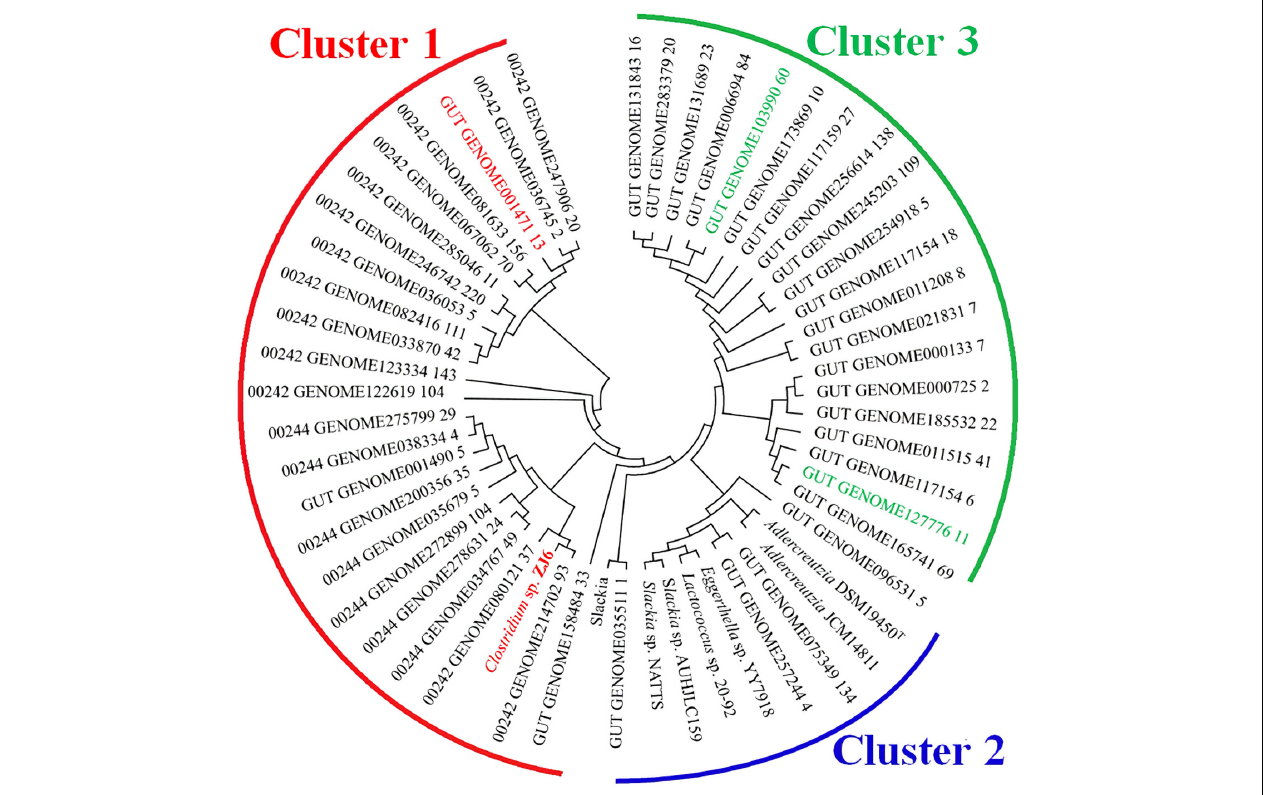
FIGURE 7 | Bioinformatics analysis of K-07020 across the human gut metagenome. Cluster 1: the similarity of amino acid sequences with K-07020 were between 79–100%; Cluster 2: the similarity of amino acid sequences with K-07020 were between 44–46%; Cluster 3: the similarity of amino acid sequences with K-07020 were about 40%. Two genes showing low sequence similarity (marked by green) and one gene showing high sequence similarity (marked by red) with K-07020 were selected for functional identification in vitro